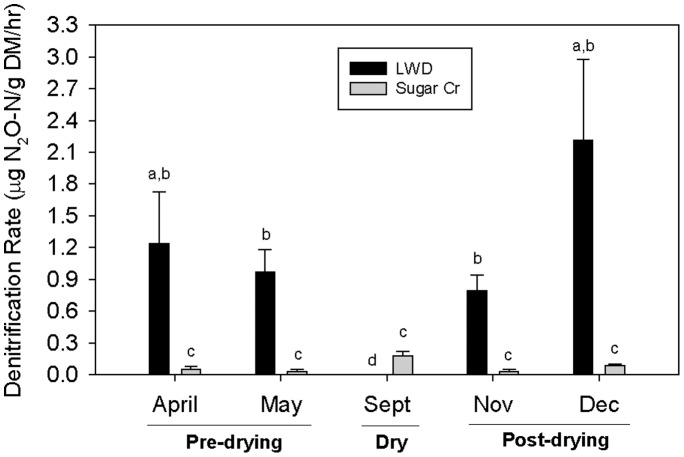
Mean denitrification rate by stream for each date.Pre-drying indicates LWD had flow; dry, no flow; post-drying, flow returned. Letters indicate significant differences (p<0.05) based on Tukey's post hoc multiple comparisons. Error bars indicate +1 SE.